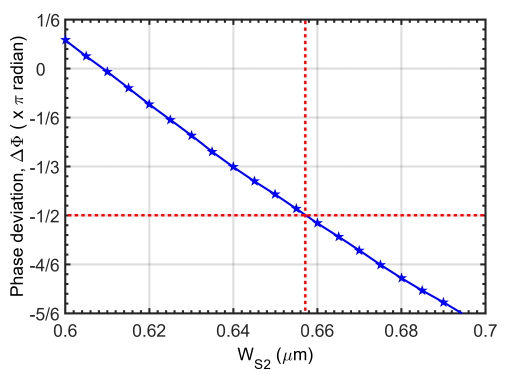
Figure 5. Phase difference as a function of W